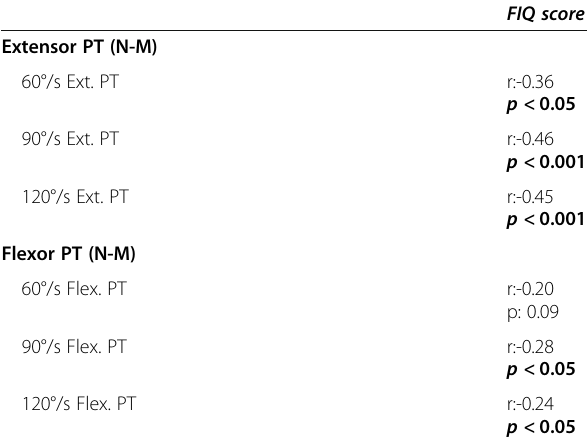
Table 3 The results of correlation analysis between FIQ score and isokinetic trunk muscle parameters